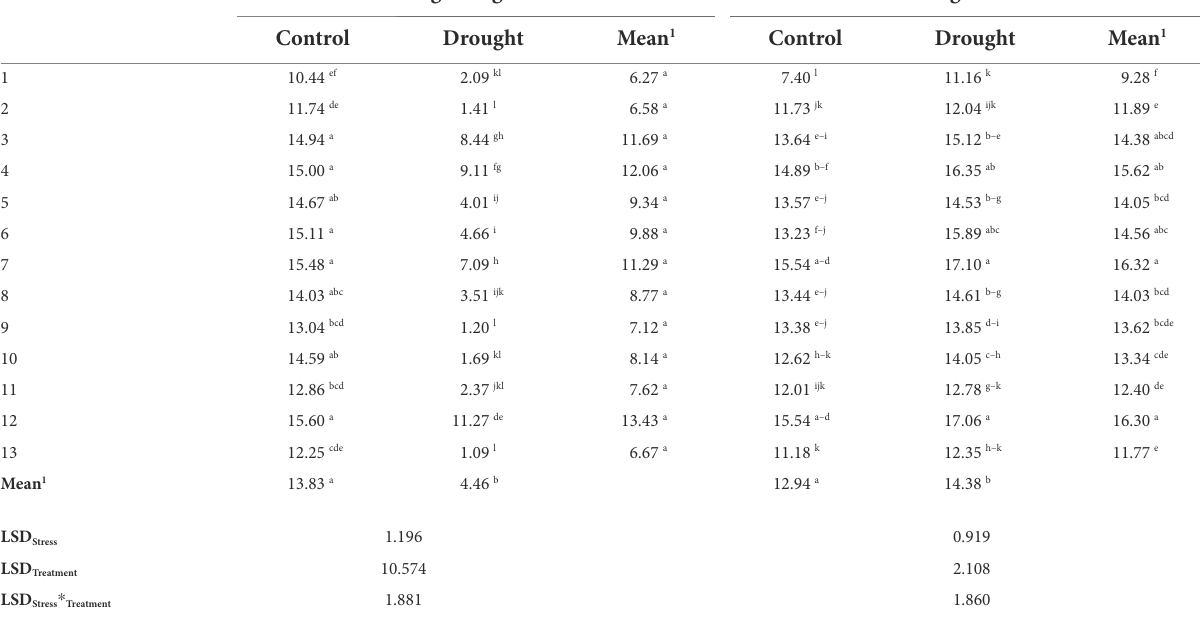
TABLE 4 The influence of the seed treatment and drought stress on CO 2 assimilation – A ( μ mol/m 2 × s) during drought stress and after regeneration. Treatment * During drought stress 2 After regeneration